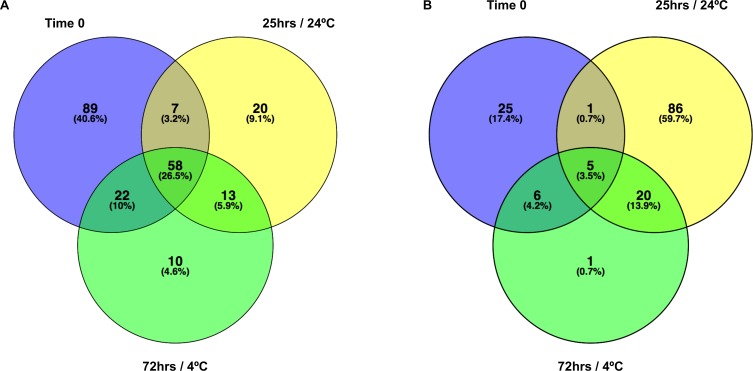
Summary of gene expression changes.(A) Venn diagram of Genes upregulated ≥ 2-fold (log counts per million) compared to the MHB control. (B) Venn diagram of Genes downregulated ≥ 2-fold (log counts per million) compared to the MHB control.